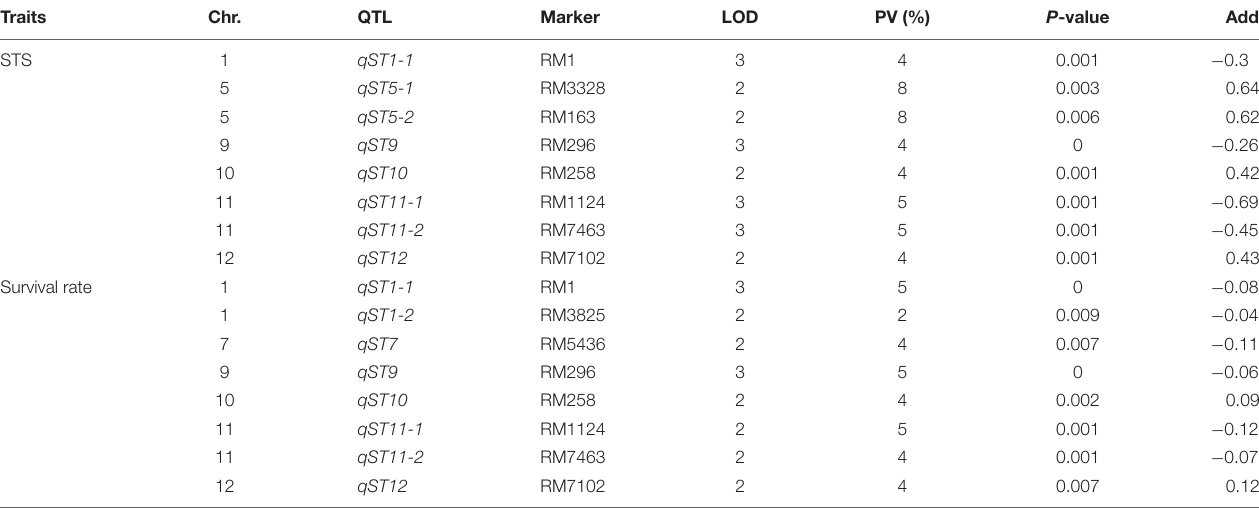
TABLE 2 | QTLs for salt tolerance at the seedling stage identified using O. rufipogon introgression lines. Traits Chr. QTL Marker LOD Add.